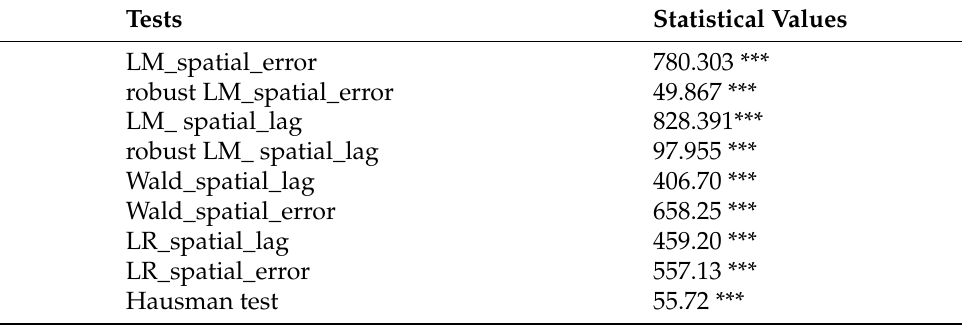
Table 6. Spatial econometric model selection